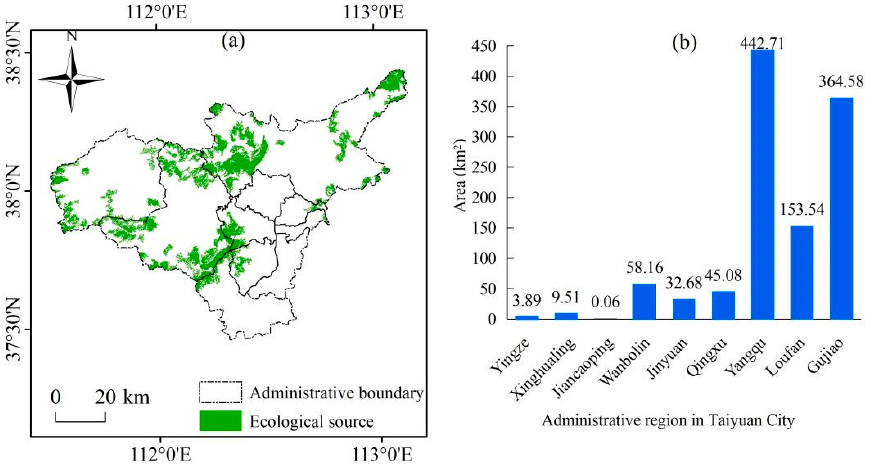
Figure 7. ( a ) Ecological source in Taiyuan City. ( b ) Ecological source areas in each administrative region.